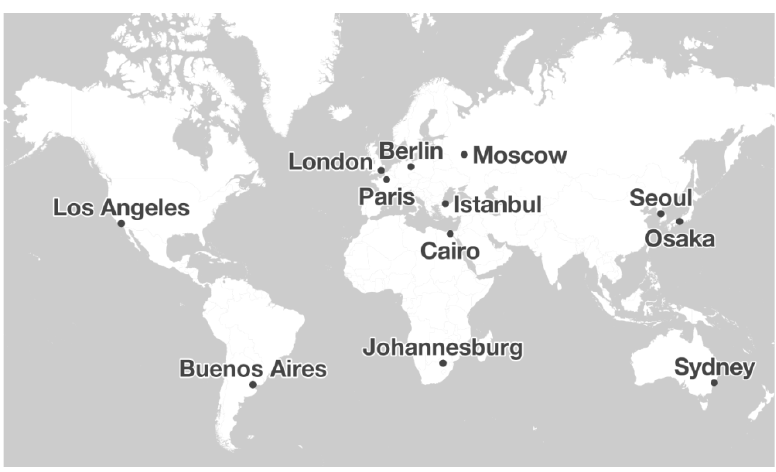
Figure 1. Overview of the selected urban areas.